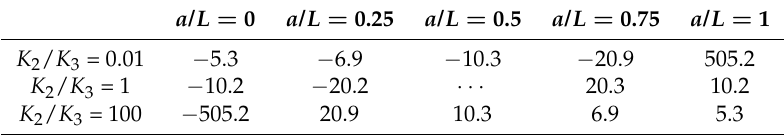
Figure 1. Discrete mechanical model. Table 1. Values of the fh parameter for several combinations K 2 / K 3 and a / L parameters.